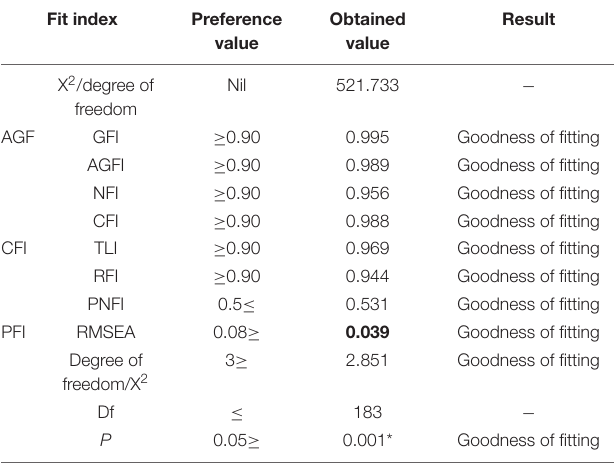
TABLE 11 | Goodness-of-fit indices of the research variables after two stepwise corrections.